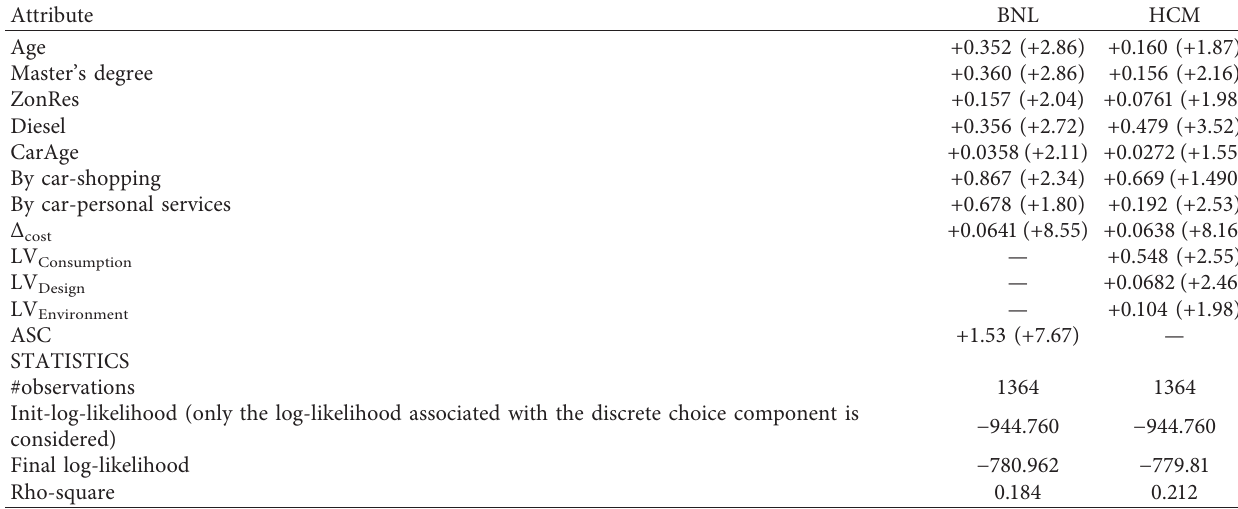
Table 11: Comparison between BNL model and HCM ( only significant attributes are listed ).